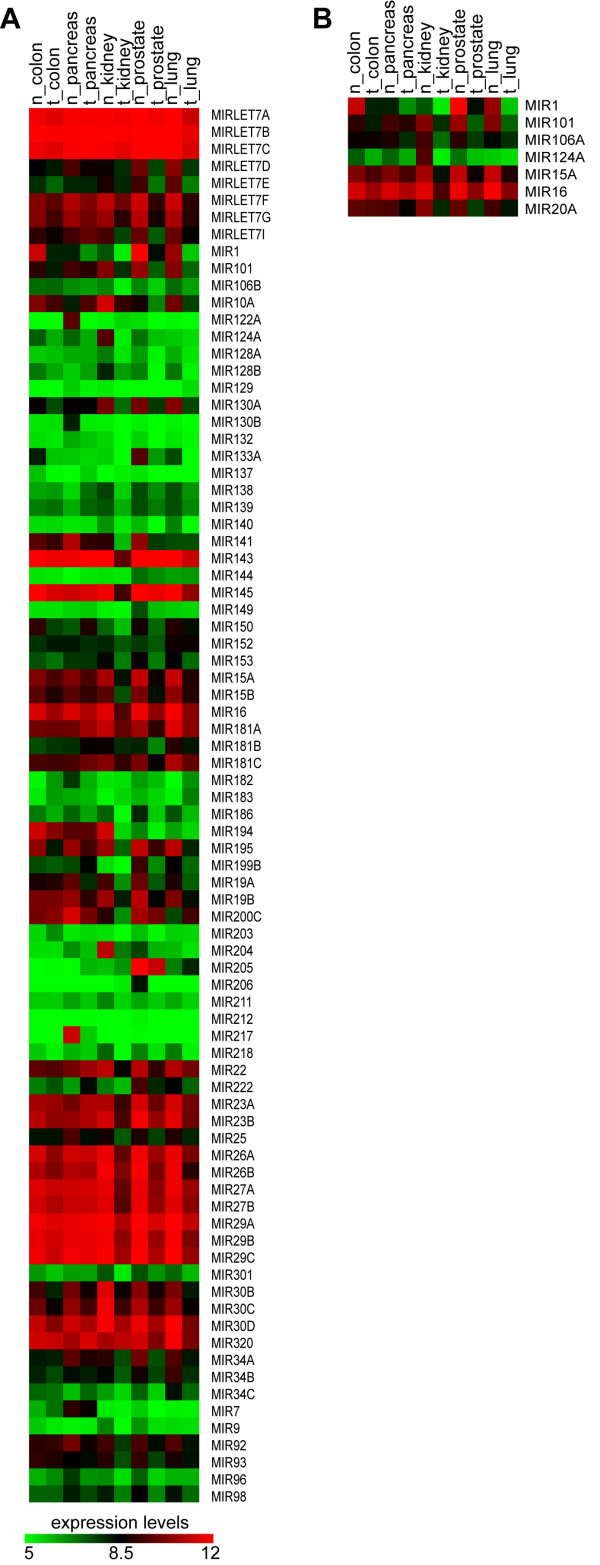
Trascriptome of AM MIRs in cancer. Panel A. Expression matrix of MIR-encoding genes computationally predicted as targeting AM. Panel B: Expression matrix of MIR-encoding genes experimentally validated as targeting AM. The colours indicate the expression levels of MIRs according to the bar shown above the matrixes. n = normal; t = tumoral.